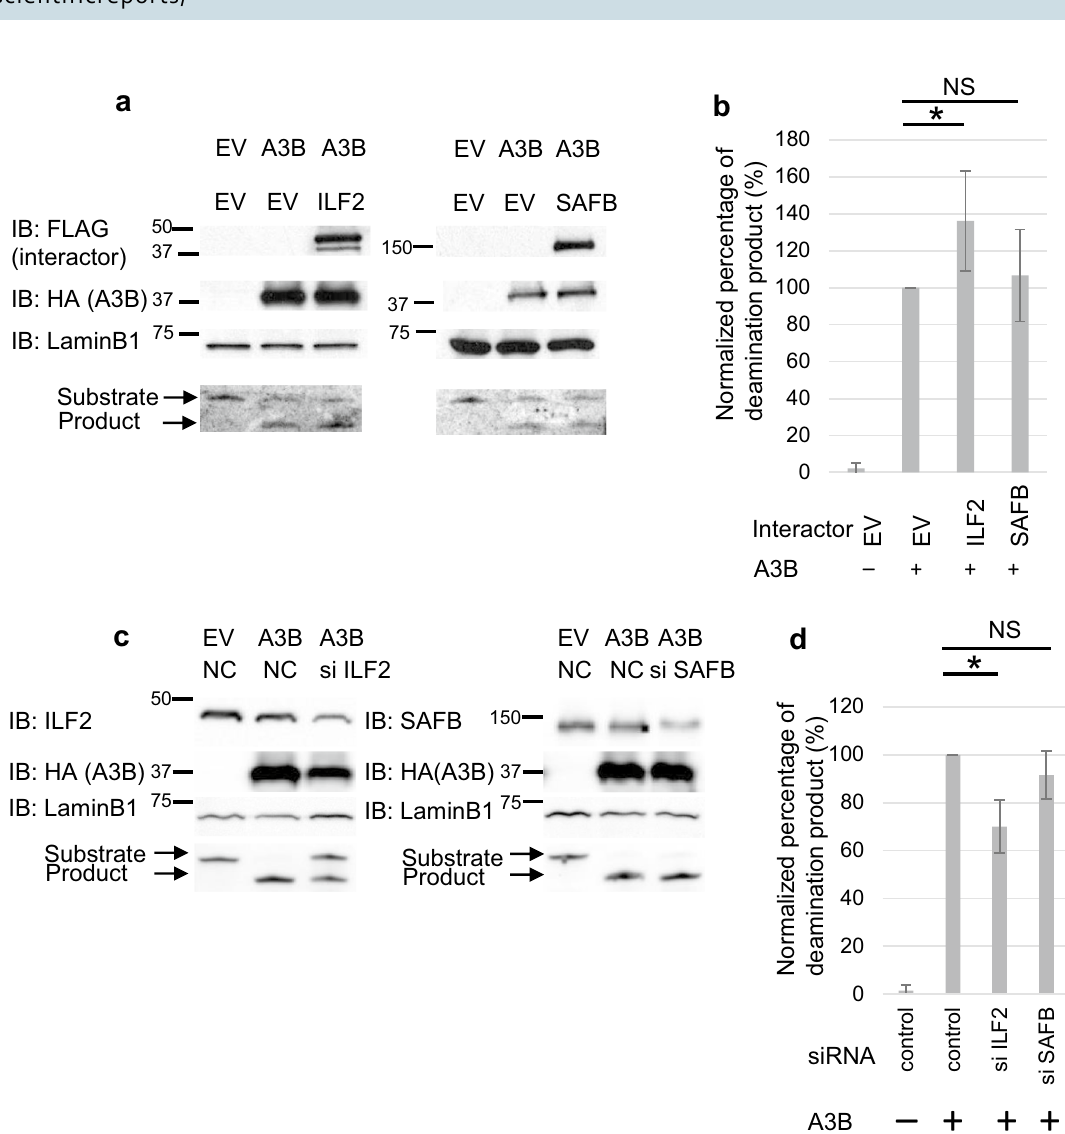
Figure 5. ILF2 enhances A3B cytidine deaminase activity. ( a ) Immunoblot analysis of interactor overexpressing HEK293T cell lysate (upper panel) and representative TBE urea PAGE analysis of A3B cytidine deaminase activity (lower panel). LaminB1 is an endogenous control. ( b ) Quantification of the cytidine deaminase activity data in five biologically independent experiments. Deaminated/total (deaminated and aminated) percentage of product was calculated and normalized by the control sample overexpressing A3B without interactors. ( c ) Immunoblot analysis of interactor knocked down HEK293T cell lysate and representative TBE urea PAGE analysis of A3B cytidine deaminase activity. ( d ) Quantification of the cytidine deaminase activity data in five biologically independent experiments. Deaminated/total (deaminated and aminated) percentage of product was calculated and normalized by the sample overexpressing A3B with control siRNA. Values are means standard deviations (error bar). Asterisks (*) show statistically significant difference p < 0.05). EV Empty vector, NC Negative control (scramble siRNA). Original blots and gels are presented in Supplementary Figure